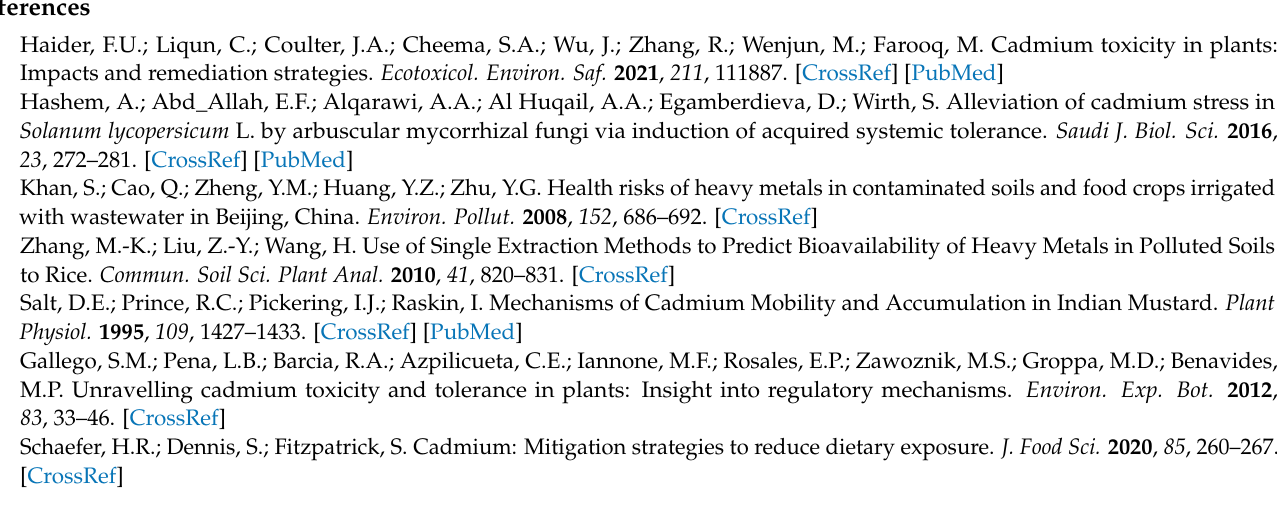
cadmium treatment—suspension cultures; Table S3: Root proteome analysis—supplementary material to Figure 4d; Table S4: Root proteome analysis—differentially abundant proteins in response to cadmium treatment; Table S5: All identified proteins; Table S6: Root metabolome analysis—differentially abundant metabolites in response to cadmium